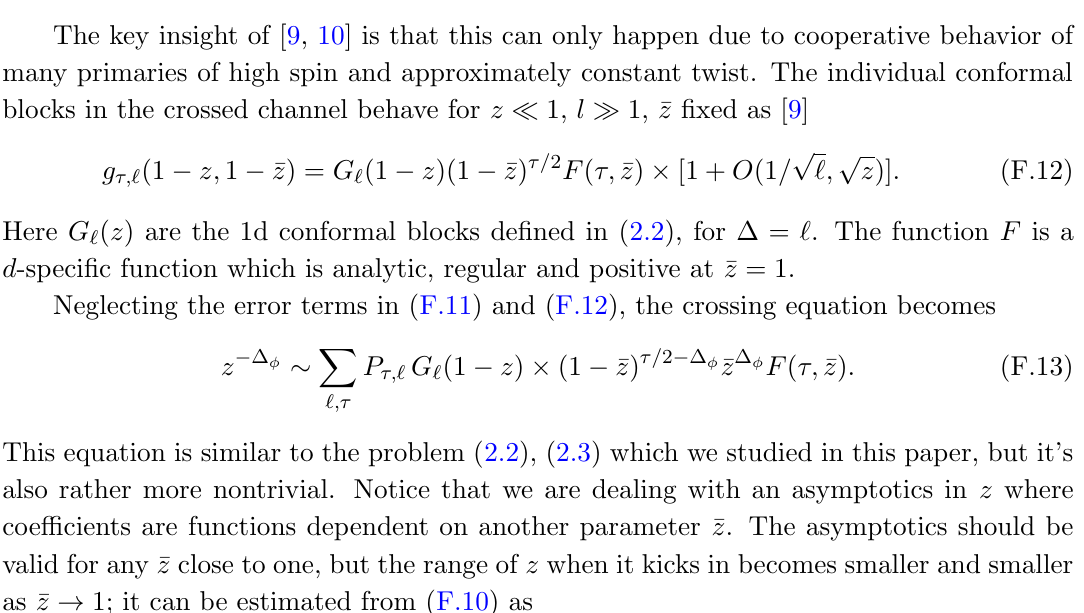
Figure 7 . The region in which we are analyzing